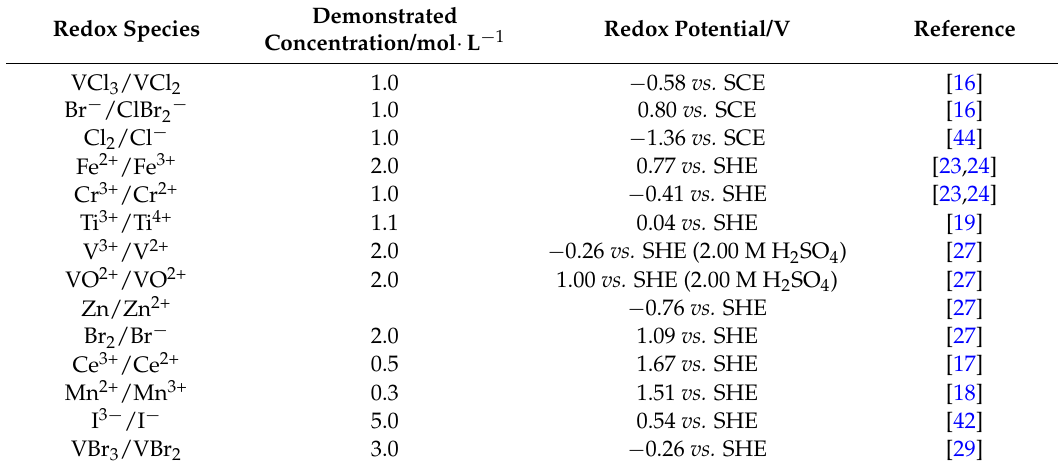
Table 1. A summary of simple inorganic ion redox species. SHE, standard hydrogen electrode; SCE, saturated calomel